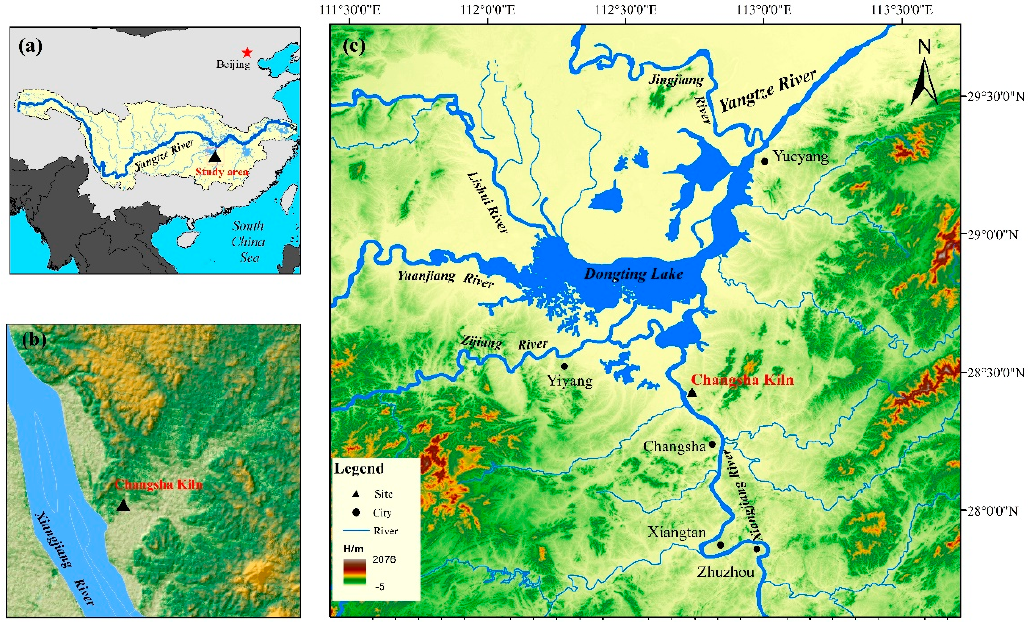
Figure 1. ( a ): Location of the study area in the Yangtze River Vally, ( b ): Geomorphological features of the Shizhu area, ( c ): An overview map of the lower reaches of the Xiangjiang River, where the Changsha kiln is marked by the black triangle.